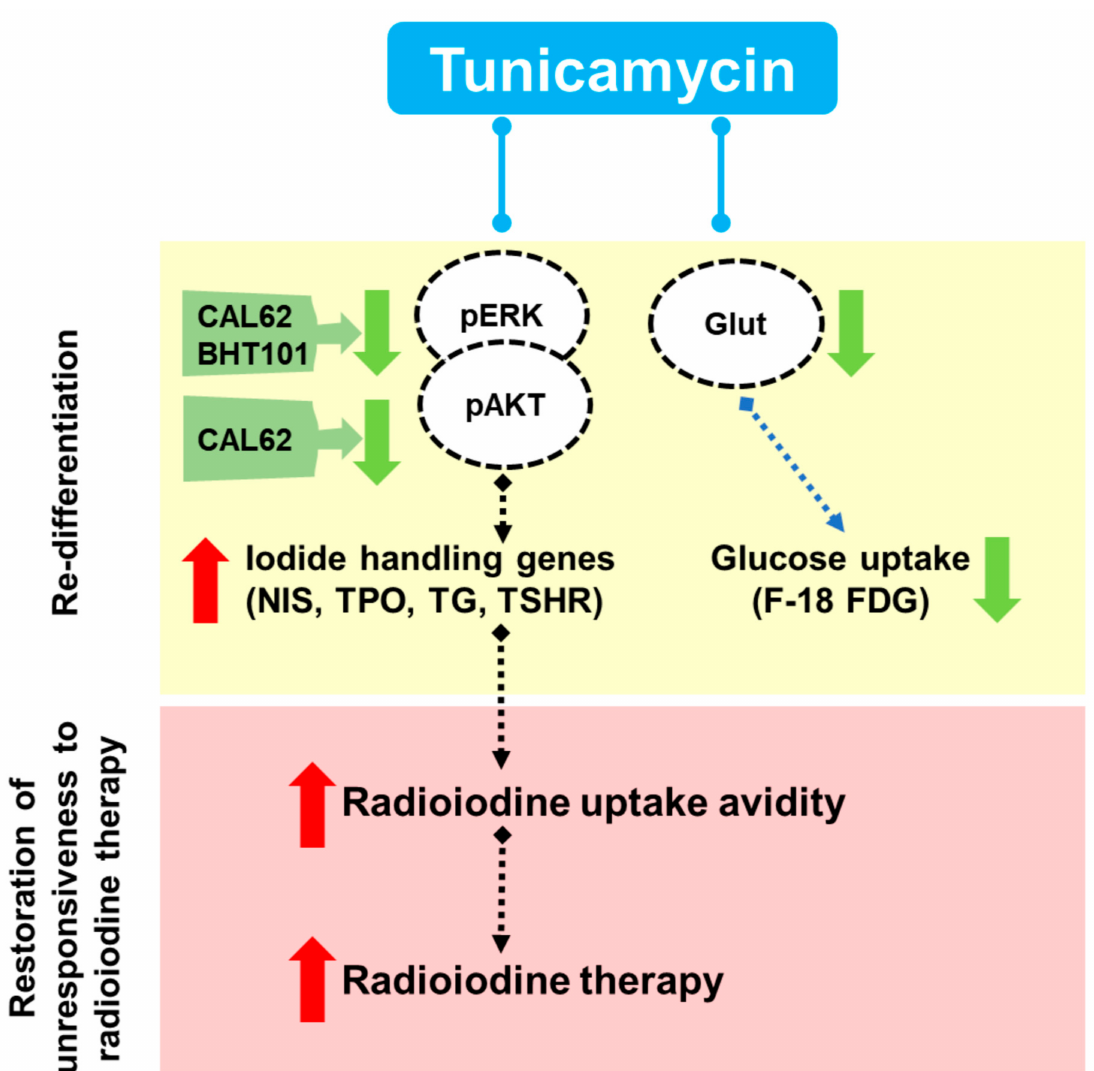
Figure 6. The proposed mode of action of TM-induced modulation of NIS function in anaplastic thyroid cancer (ATC) cells. TM restored the iodide-handling genes such as NIS, thyroid peroxidase (TPO), thyroglobulin (TG), and -stimulating hormone receptor